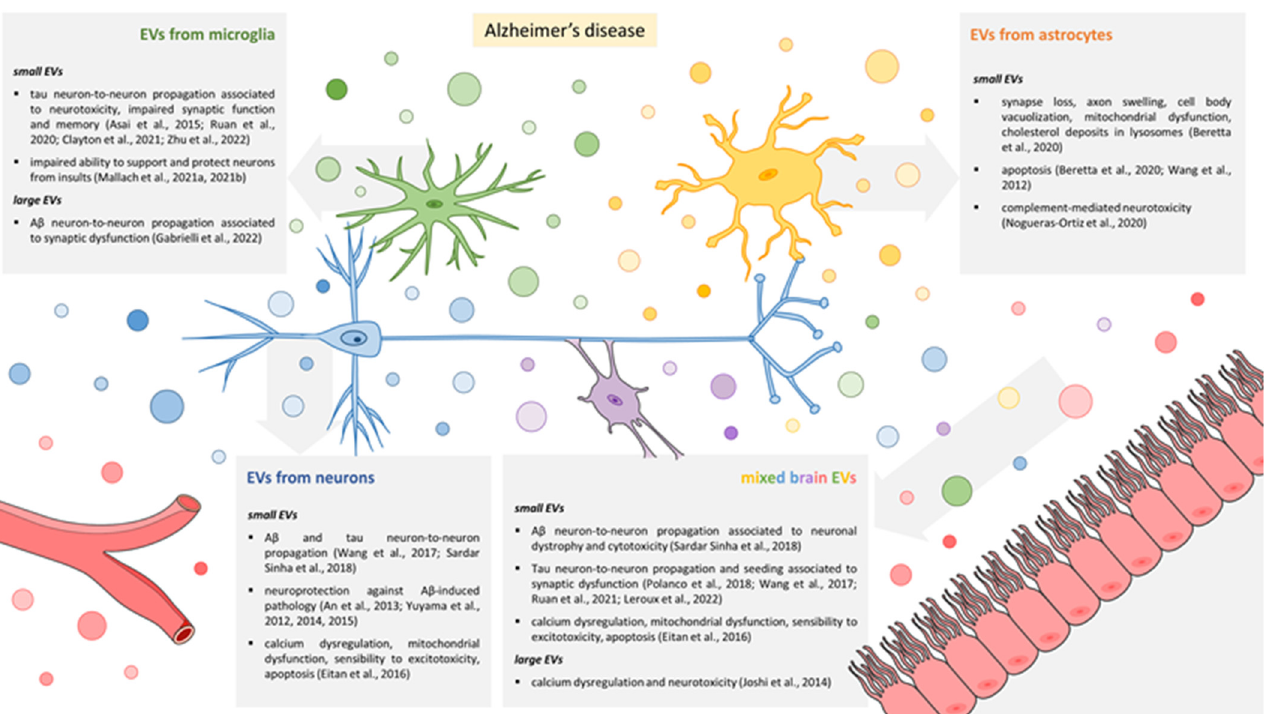
Figure 1. Effects of EVs released by brain cells on neuronal function in AD. Graphic summary of the effects of EVs from different brain cell types on neuronal function in AD pathology. Parts of the